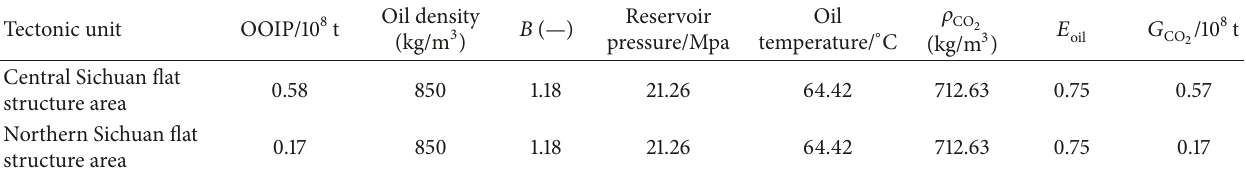
Table 9: Storage potential of CO 2 geological storage in depleted oil fields.